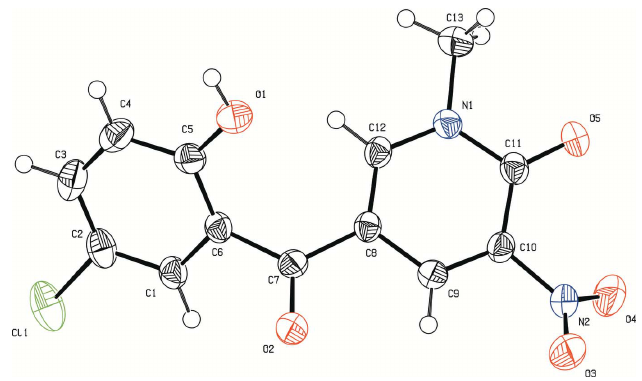
Figure 1 The molecular structure of the title compound, showing the atom labelling. Displacement ellipsoids are drawn at the 50% probability level.